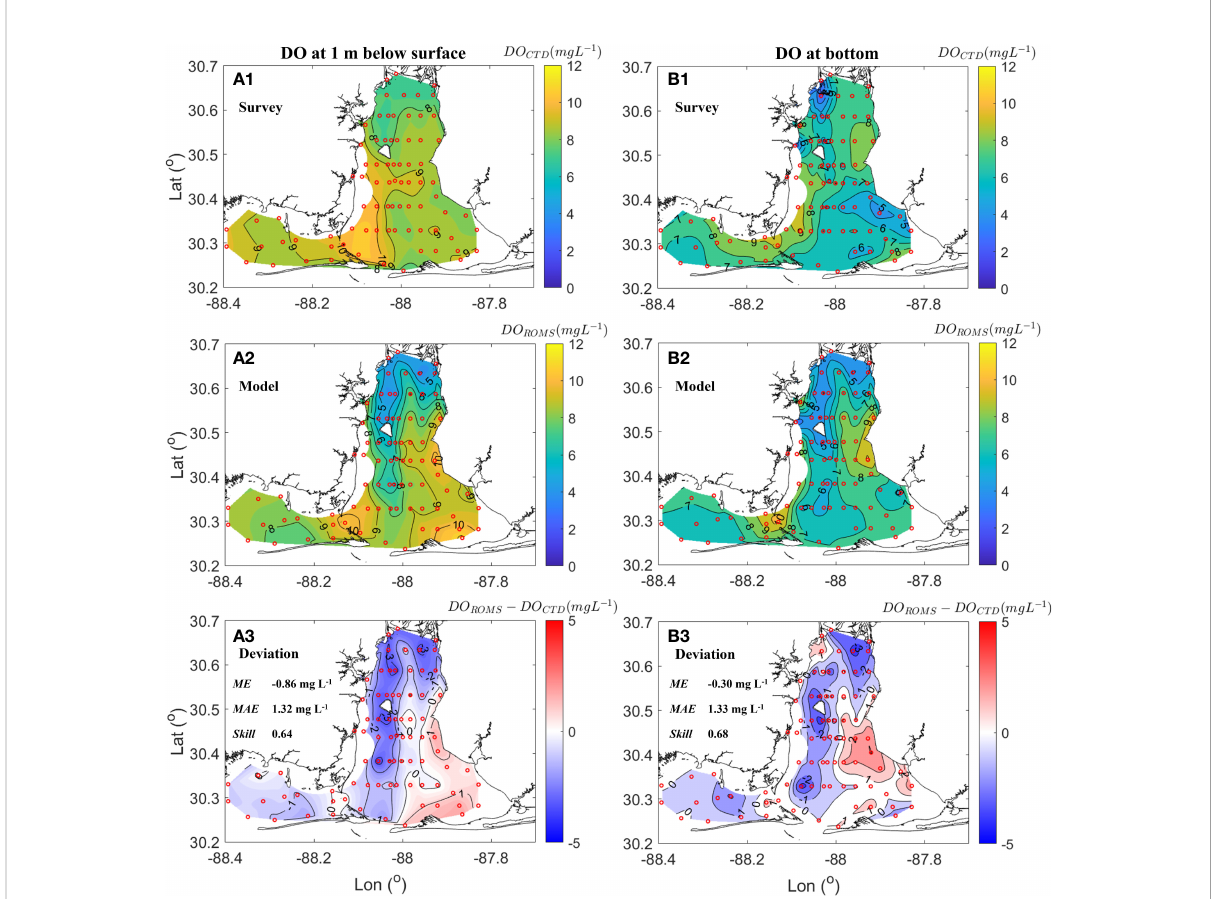
FIGURE 4 Spatial patterns of dissolved oxygen (DO) concentration during April 22-23. Figure includes (A.1) DO at 1 m below the surface from CTD pro fi ling, (A.2) modeled DO at 1 m below the surface, (A.3) model deviation at 1 m below the surface (modeled DO from ROMS – observed DO from CTD) shown with ME, MAE, and Skill, (B.1) DO at bottom from CTD pro fi ling, (B.2) modeled DO at the bottom, and (B.3) bottom model deviation (modeled DO from ROMS – observed DO from CTD shown with ME, MAE, and Skill. Red circles in all panels denote CTD